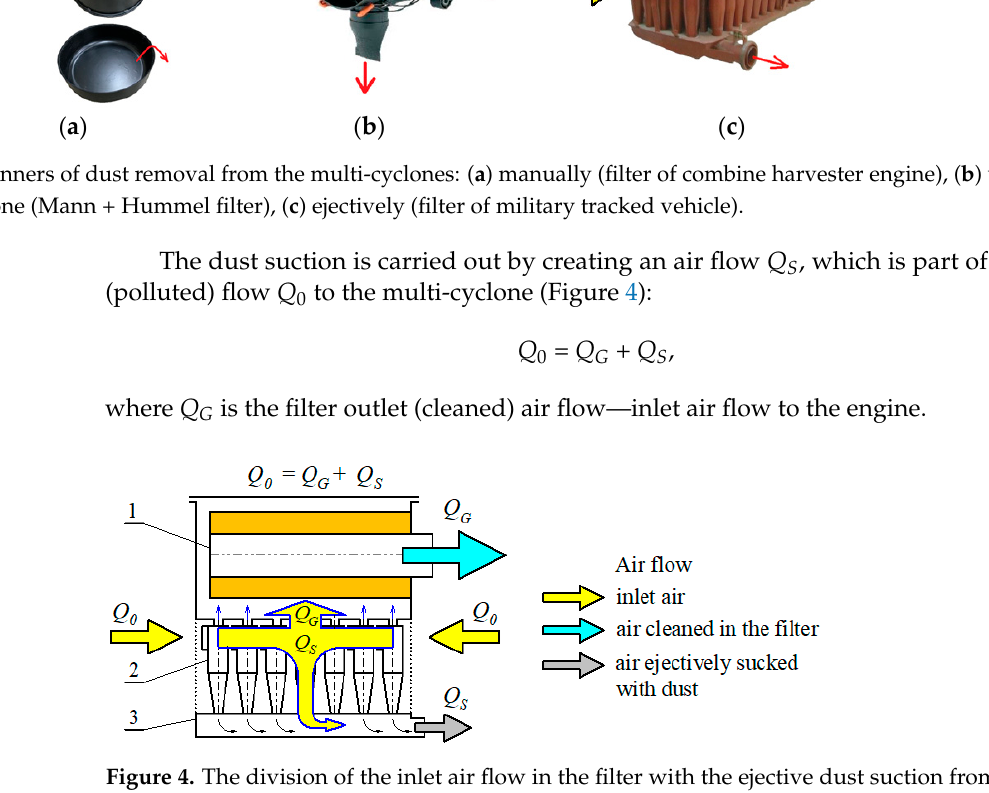
Figure 4. The division of the inlet air flow in the filter with the ejective dust suction from the dust collector: 1—filtration baffle, 2—multicyclone, 3—dust collector. collector: 1—filtration baffle, 2—multicyclone, 3—dust collector: 1—filtration baffle, 2—multicyclone, 3—dust collector.